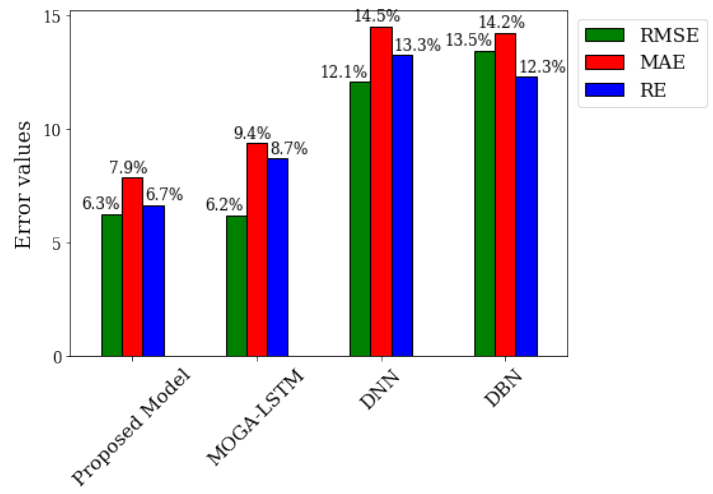
Figure 13. Performance comparison for RUL estimators at